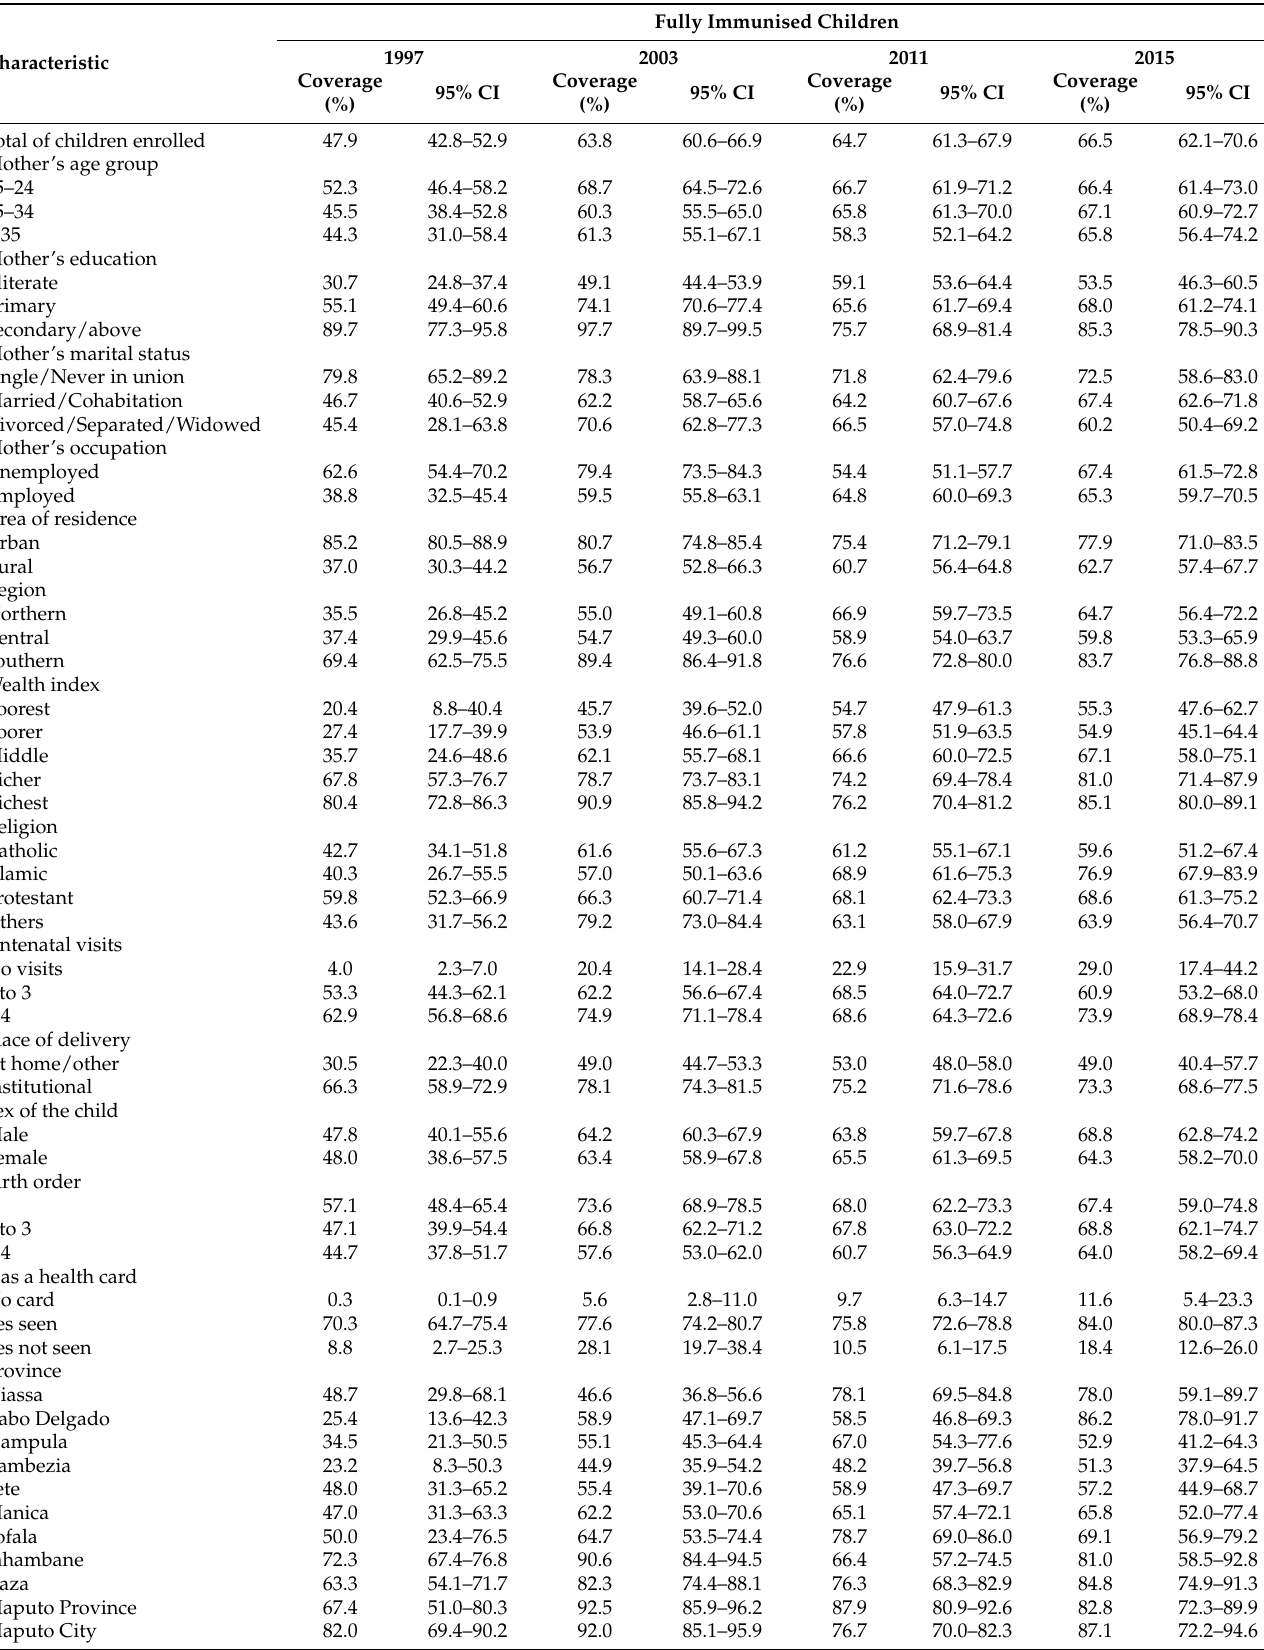
Table 2. Immunisation coverage in children from 12 to 23 months, 1997 to 2015